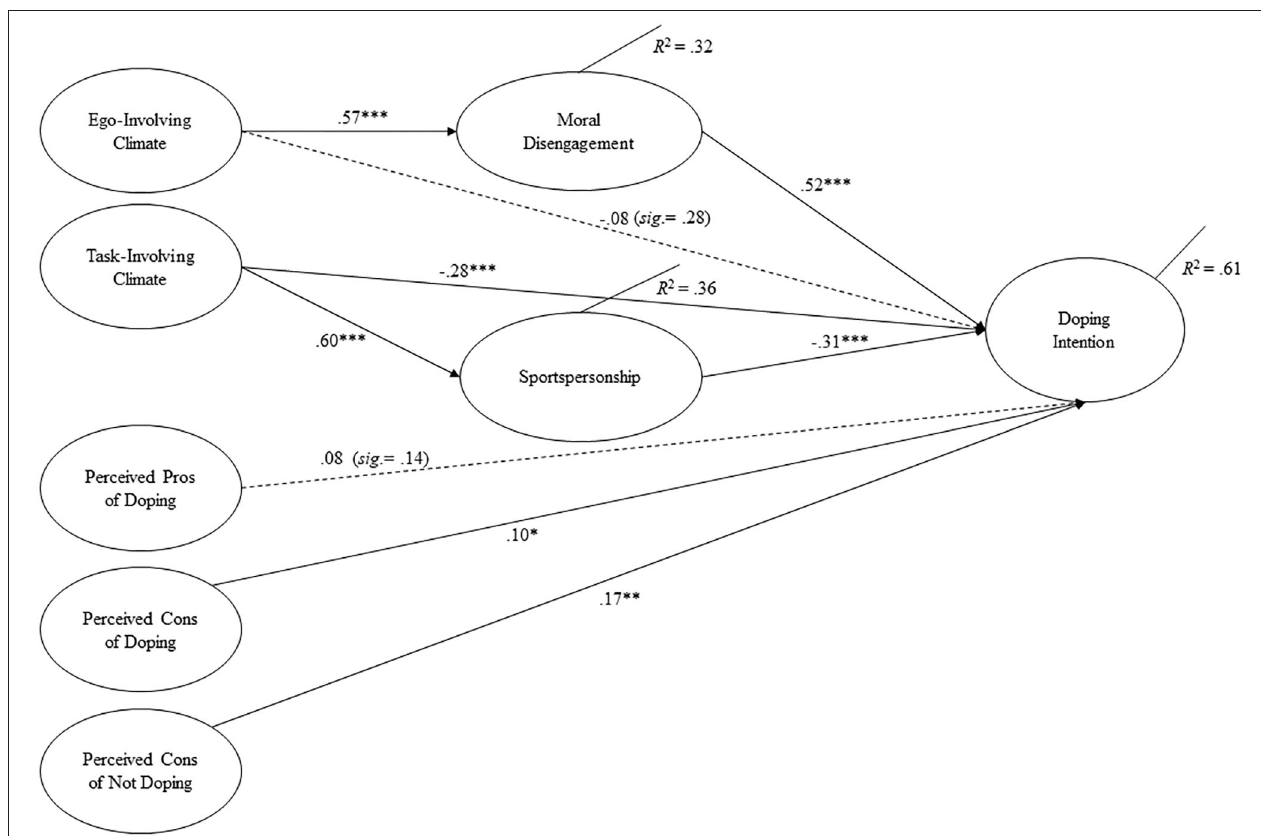
FIGURE 2 | Final structural model with standardized path